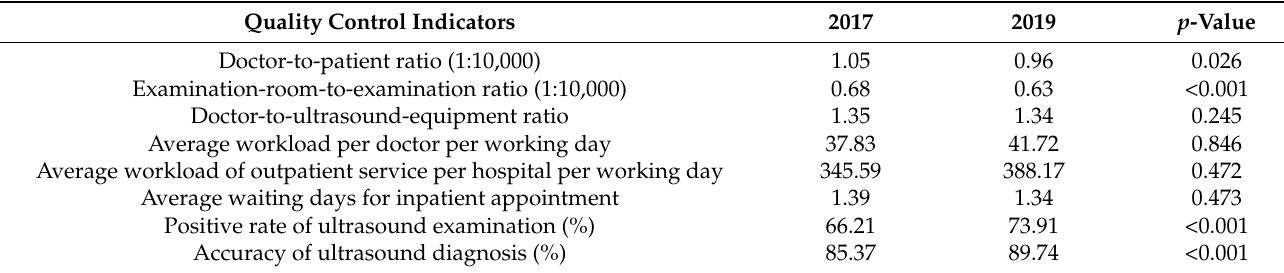
Table 2. Performance on quality control indicators in enrolled hospitals.